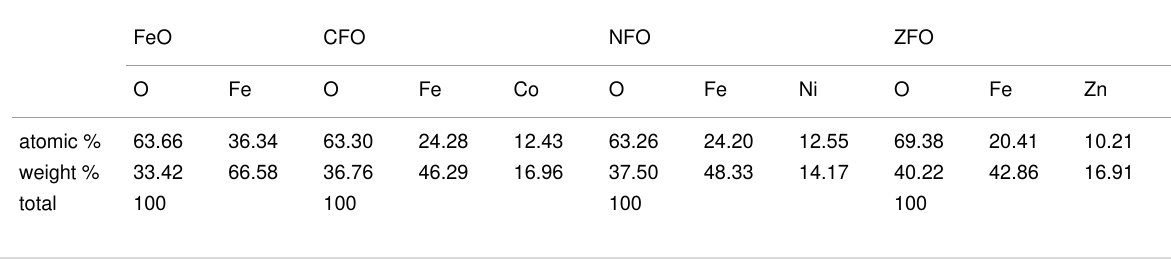
Table 2: EDS analysis showing elemental composition for MFe 2 O 4 (M = Fe, Co, Ni, Zn)